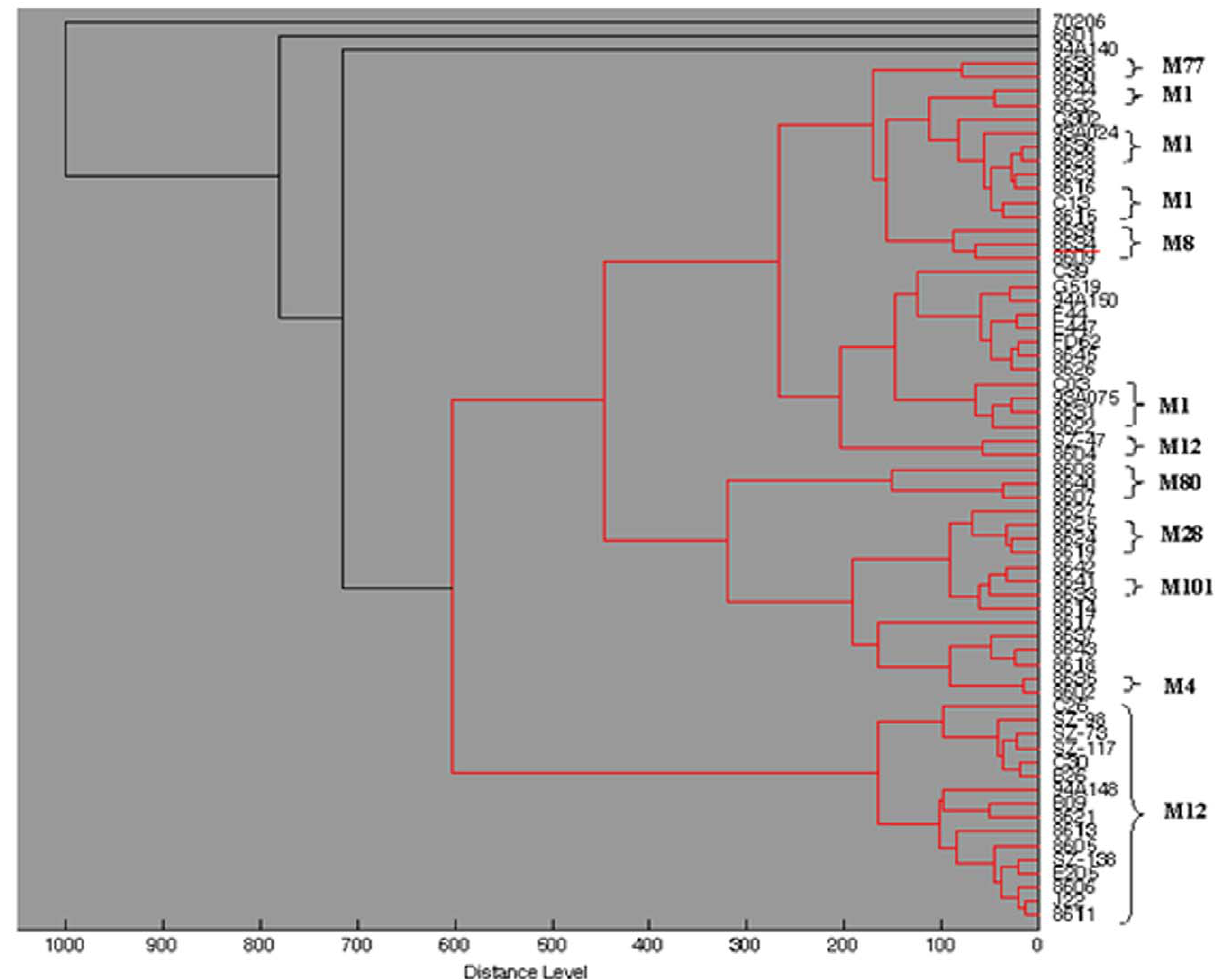
Figure 2. Score Oriented Dendrogram for 65 streptococcus pyogenes. Using a critical distance level of 600, the wrongly identified isolates were clustered outside of the other isolates. At a critical distance level of about 450, most isolates (16 of 18) of M12 were branched. At a critical distance level of about 270, most isolates (12 of 13) of M1 were branched, although not in one cluster group. At a critical distance level of about 200, M80, M28, M101 and M4 were grouped well. doi:10.1371/journal.pone.0047152.g002 PLOS ONE |